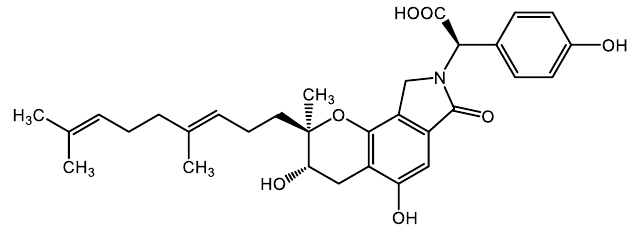
Figure 5. Chemical structure of SMTP-44D.